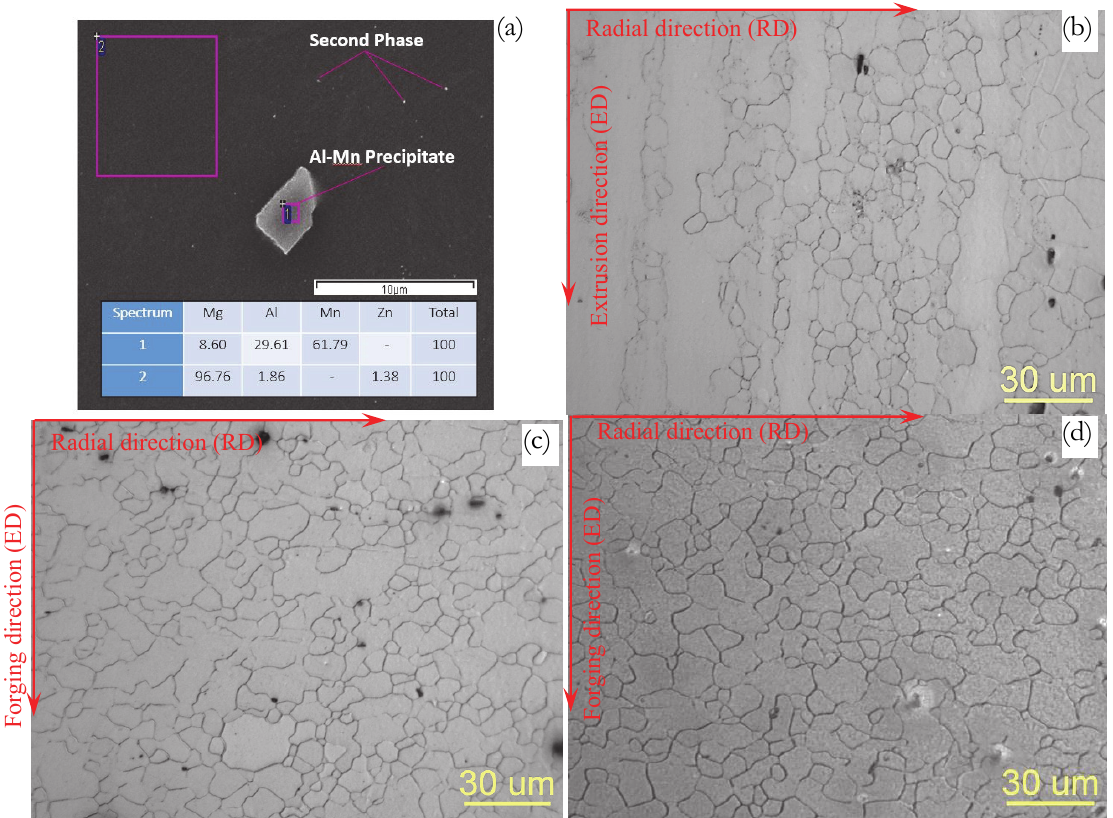
Figure 2: Microstructures of AZ31B alloy in different conditions, (a) typical SEM image with EDS analysis on matrix and prominent intermetallic and OM image of (b) as-extruded, and extruded followed by forging at 400°C temperature for the rate of (c) 10 mm/min (S1) and (d) 100 mm/min (S2).